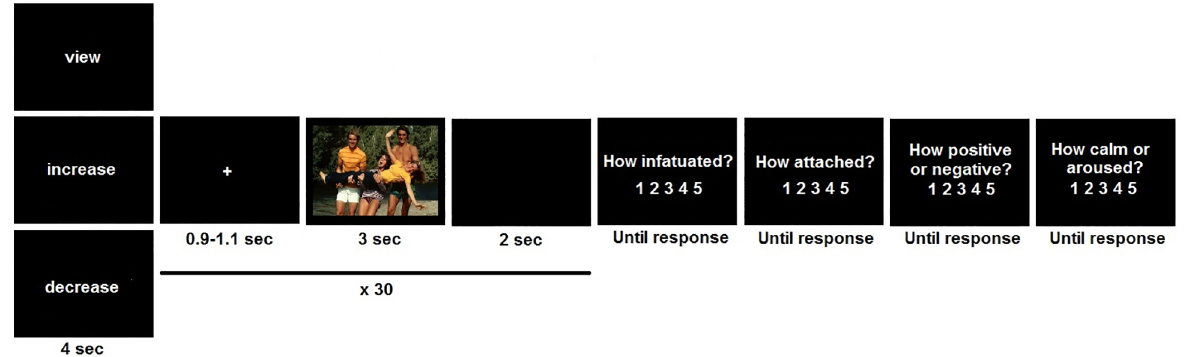
Fig 1. Overview of blocks and trials in the regulation task. Please note that the stimulus in this figure is not actually one of the pictures that were submitted by the participants. Instead, it is an IAPS picture [53] that resembles the kinds of pictures that participants